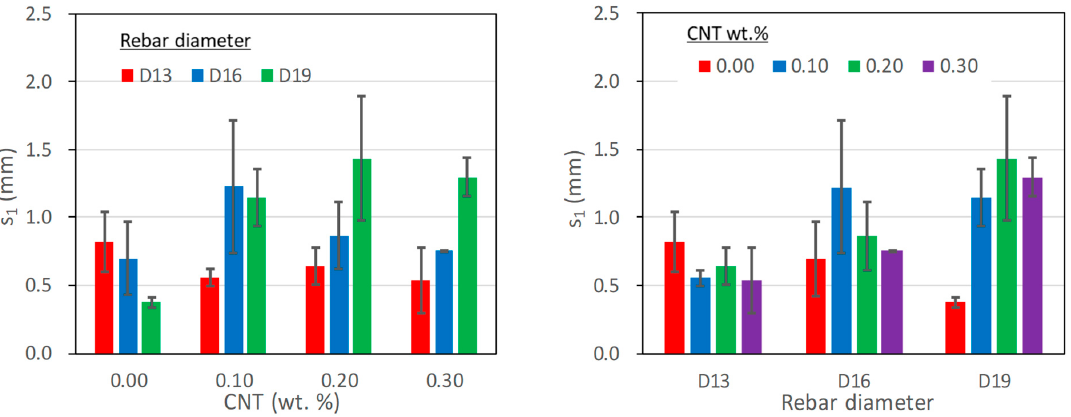
Figure 10. The effect of CNTs mix ratio and rebar diameter on the slip corresponding to the bond strength.